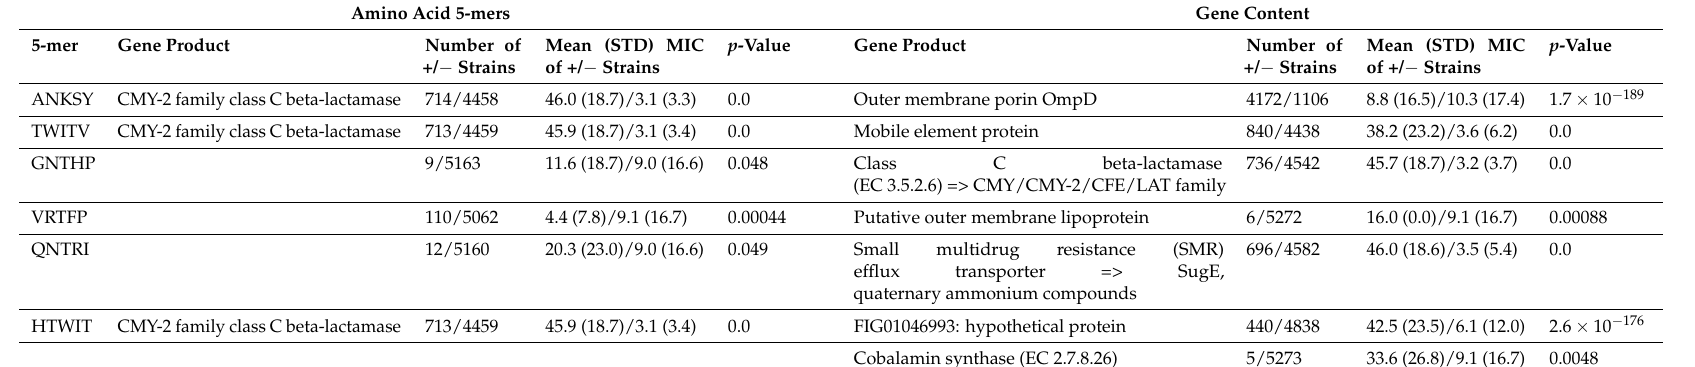
Table A8. Important genes found for S. enterica and cefoxitin by amino acid 5-mer gene content method.